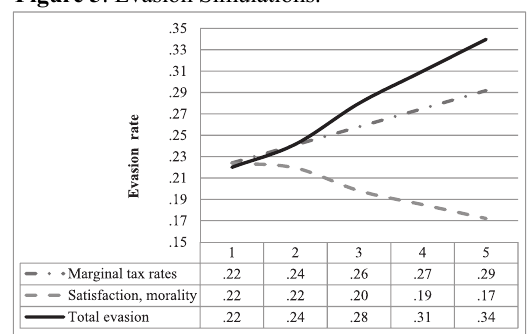
Figure 5 : Evasion